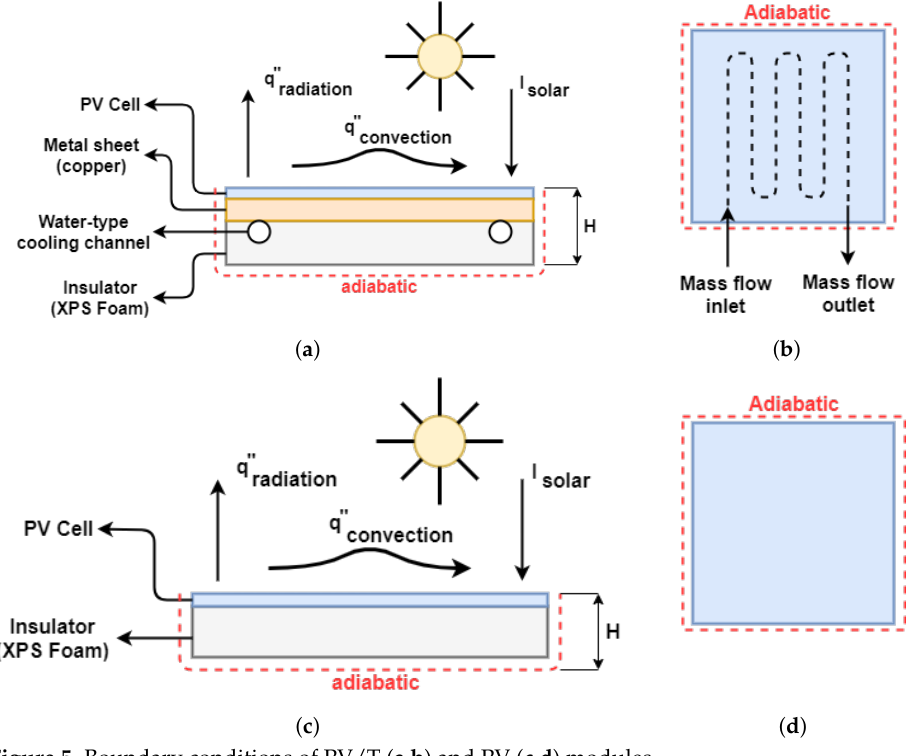
Figure 5. Boundary conditions of PV/T ( a , b ) and PV ( c , d )